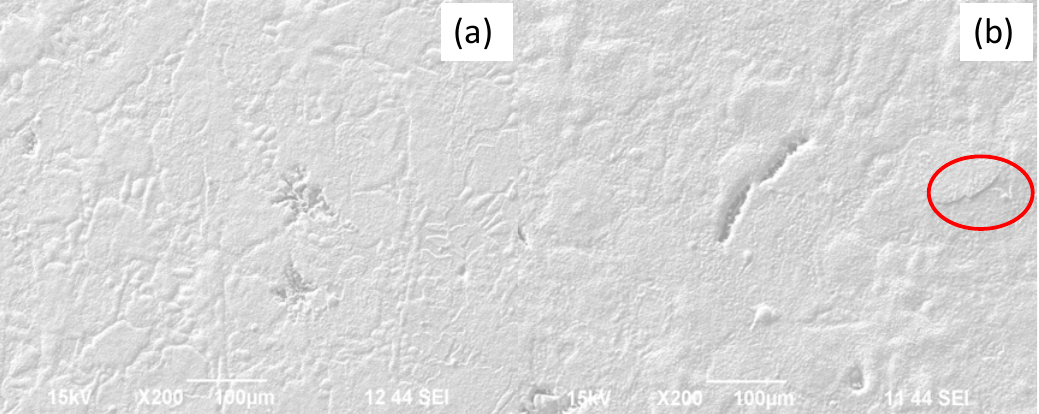
Figure 3. SEM images of the IC roll surface morphologies oxidized in dry air at ( a ) 650 °C and ( b ) 700 °C.